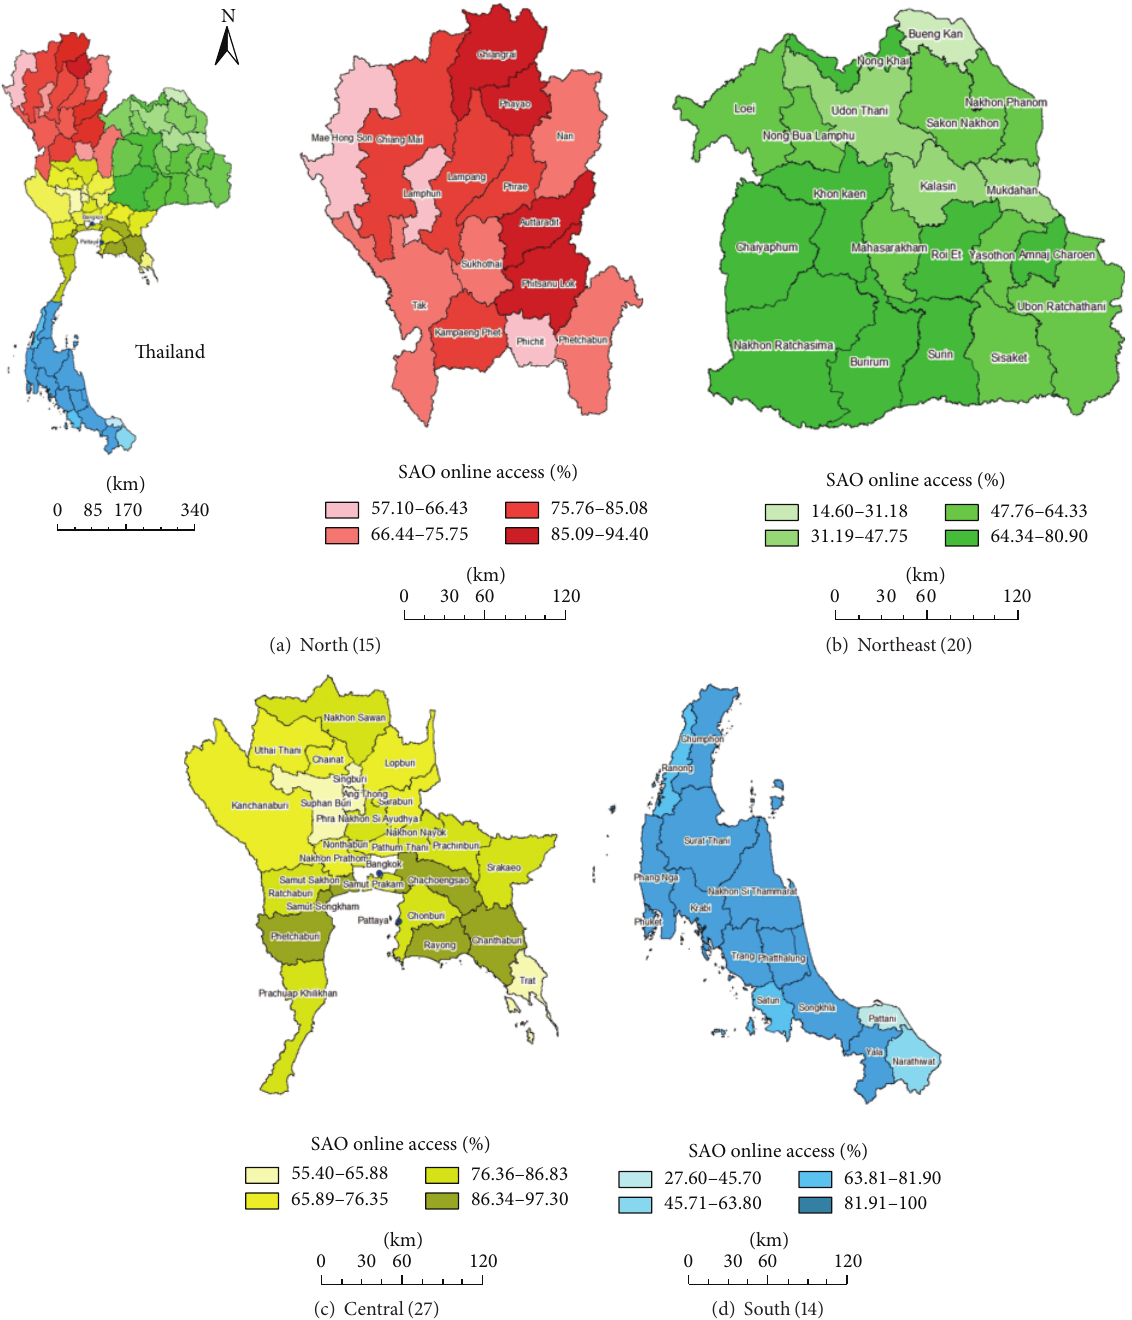
Figure 2: Maps on a 2013 current status of SAO websites accessible online in conjunction with the rural development in four regions (no. of provinces) of Thailand after 2011. A provincial boundary is shown for the percentage of online access in rural settings governed by the SAOs